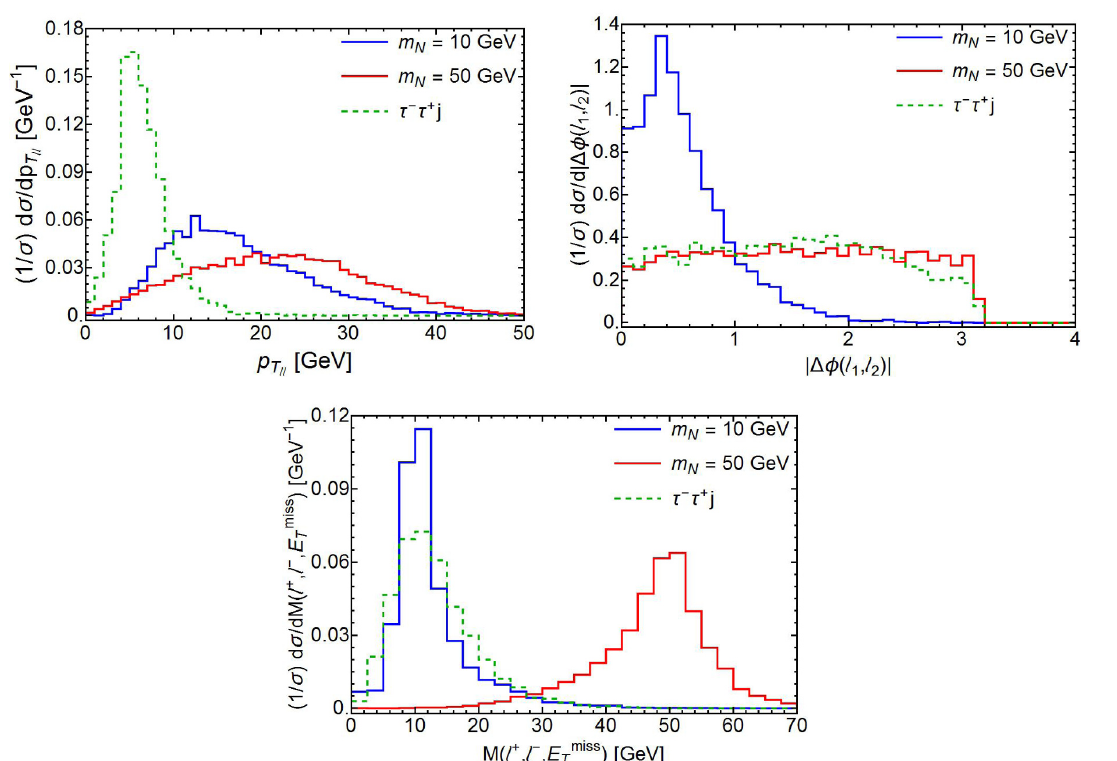
Figure 7 . Kinematic distributions of p T m N = 10 and 50 GeV and the τ + τ − j background in the e + µ − j + E miss the p T cut in table ‘‘